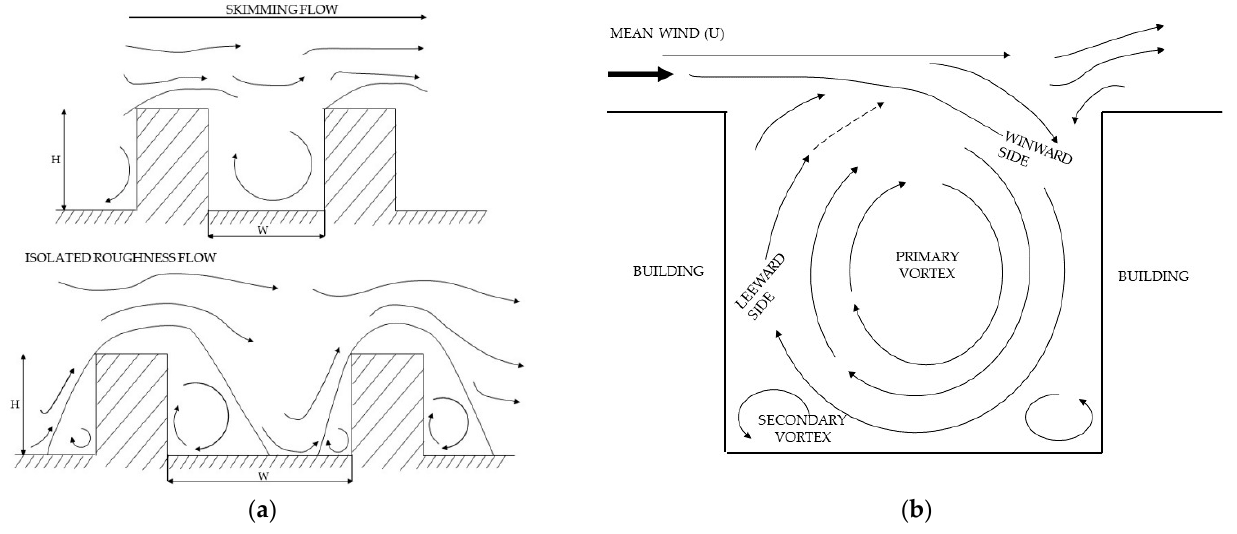
Figure 1. ( a ) Different flow regimes for various H/W configurations, according to [39]. ( b ) Detailed description of the canyon vortex, according to [40]. Lines are representing flow streamlines.